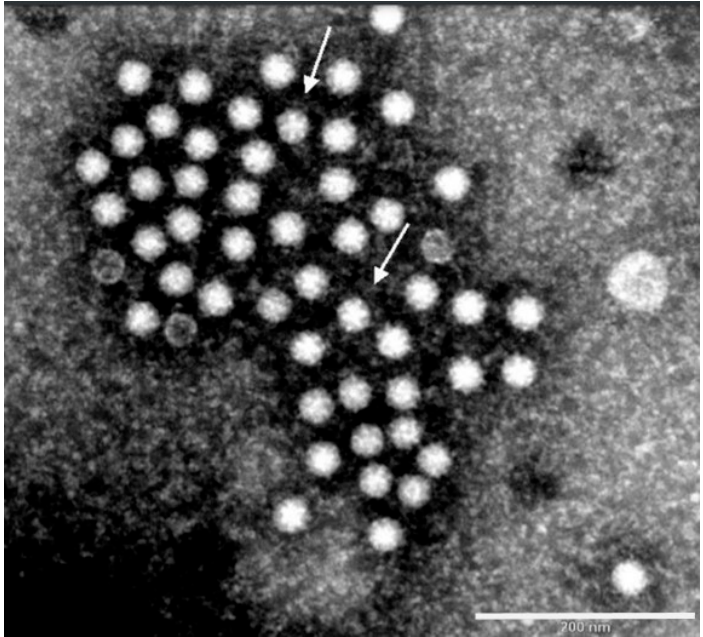
Figure 2. Astrovirus particles using electron microscopy (CVUA-Stuttgart 2010), showing five or six-rayed star-shaped particles (white arrow) using negative contrast EM (scale bar: 200 nm). The diagnosis of adenoviruses depends on virus isolation and molecular identification.